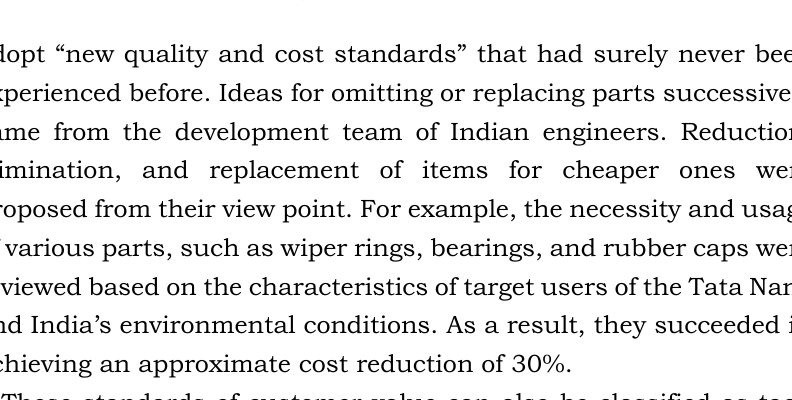
Figure 3. Conventional wiper system (above) and DNIN-developed wiper system for Tata Nano